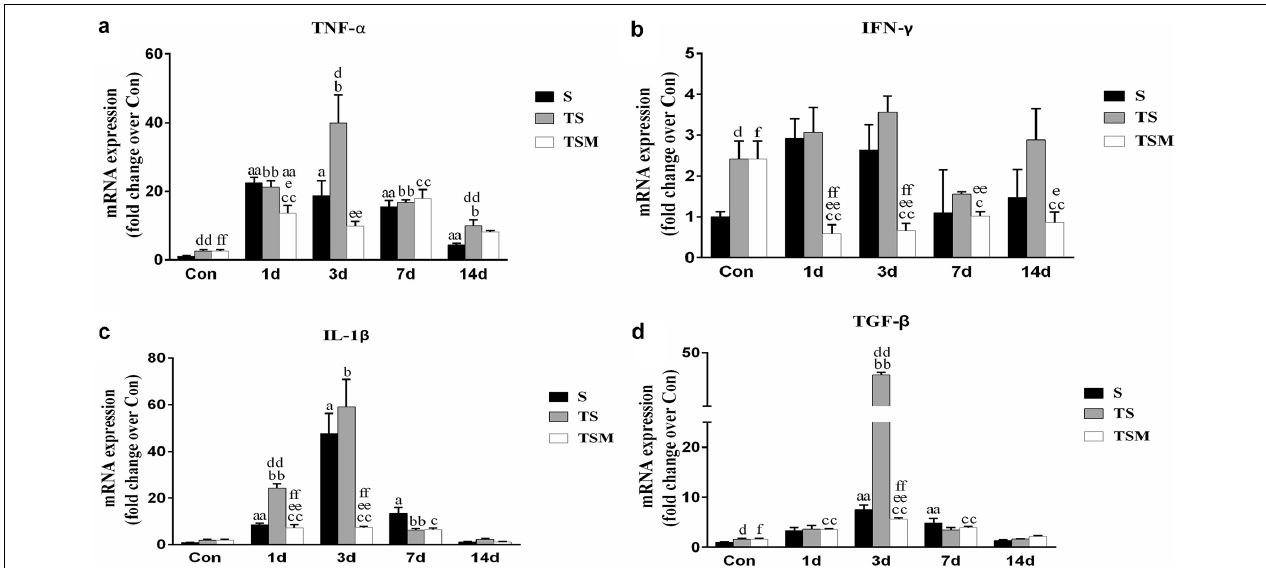
FIGURE 7 | Effects of MGF treatment on the expression of inflammatory cytokines in injured skeletal muscle after macrophage depletion. (a) The expression of TNF- α ; (b) The expression of IFN- γ ; (c) The expression of IL-1 β ; (d) The expression of TGF- β . S, muscle contusion group; TS, muscle contusion and macrophage depleted group; TSM, muscle contusion, macrophage depletion, and MGF treated group. Data are means ± SEM, n = 8; a Significant difference from Scon, p < 0.05; aa p < 0.01. b Significant difference from TScon, p < 0.05; bb p < 0.01. c Significant difference from TSMcon, p < 0.05; cc p < 0.01; d Significant difference between group TS and group S, p < 0.05; dd p < 0.01; e Significant difference between group TS and group TSM, p < 0.05; ee p < 0.01; f Significant difference between group TSM and group S, p < 0.05; ff p <